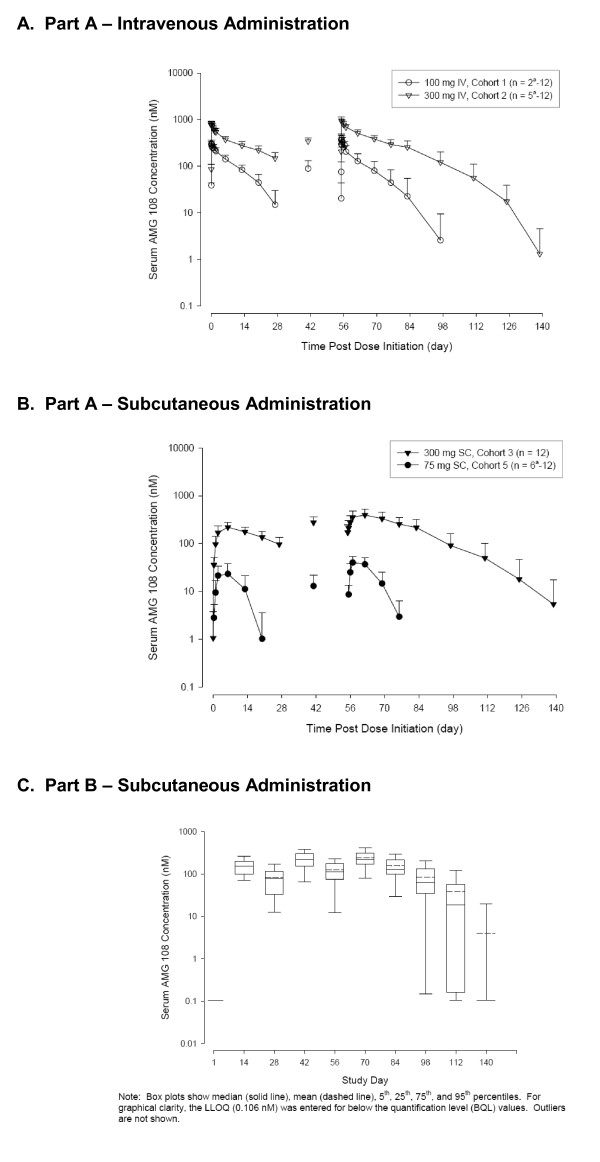
Pharmacokinetic results: AMG 108 serum concentrations. (a) part a, intravenous administration; (b) part a, subcutaneous administration; (c) part b, subcutaneous administration. IV, intravenous; LLOQ, lower limit of quantification; nM, nanomole; SC, subcutaneous.